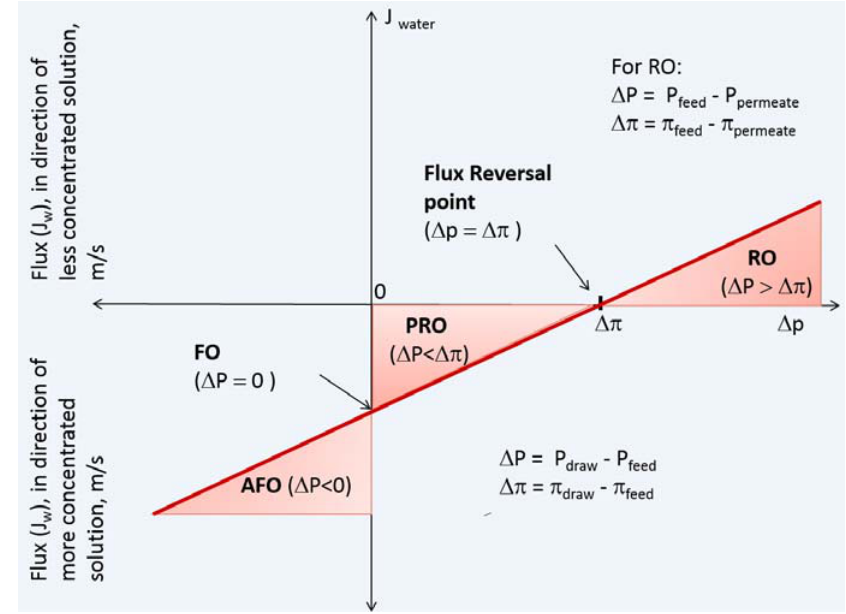
Figure 2. Relationship between water flux and applied pressure in RO, PRO, FO, and